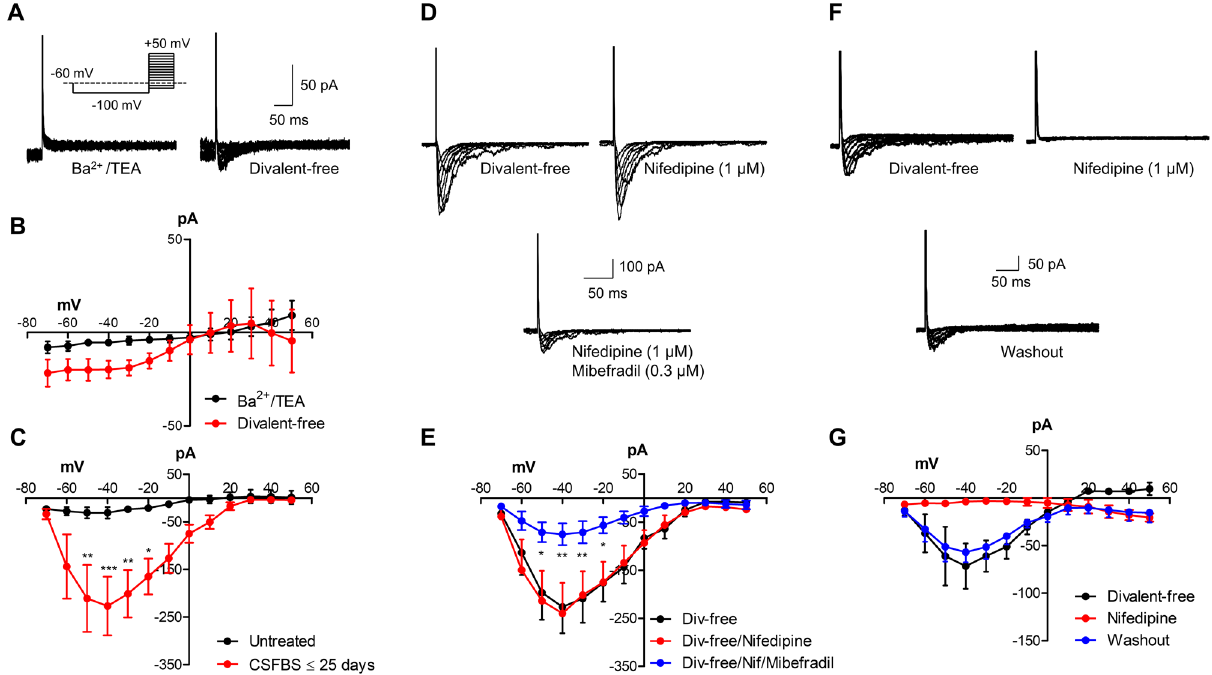
Figure 5. Voltage-gated inward currents in LNCaP emerge after CSFBS culturing. ( A ) Representative recordings from untreated LNCaP in Ba 2+ /TEA Hanks, and detection of inward currents in divalent-free solution. ( B ) Summary current–voltage plot of mean current from 6 cells (N = 2 cultures) in BaLNCaP exhibited high K/TEA and divalent free conditions. ( C ) Summary current–voltage plot of divalent-free currents in untreated LNCaP (n = 8, N = 2 cultures, overlapping with n = 6 data from panel B ) and CSFBS-LNCaP up to 25 days treatment (n = 11, N = 4). Two-way ANOVA, Bonferroni post-hoc tests showed significant increase in mean current at − 50, − 40, − 30 and − 20 mV (*p < 0.05, **p < 0.01; ***p < 0.001). ( D ) Representative currents in divalent-free from an LNCaP cultured in CSFBS or 25 days in the presence of nifedipine and upon further addition of mibefradil. ( E ) Summary current–voltage plot for the effect of nifedipine (1 μM) alone and combined with (0.3 μM mibefradil) in CSFBS treated cells (n = 6; N = 4) where mibefradil significantly reduced current amplitude. ( F ) In CSFBS treated cells (14 days), nifedipine-sensitive currents were less frequently encountered and the effect of nifedipine was largely reversible. ( G ) Summary current–voltage plot for 3 cells from one culture that exhibited nifedipine-sensitive inward